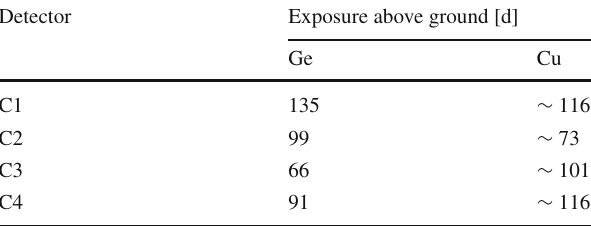
Fig. 13 Contribution of the decay of cosmogenic isotopes evaluated with the MC simulation in comparison to background data of C1 in April 2018 in the highE range Table5 TotalexposureabovegroundoftheGeandCuemployedinthe CONUS experiment. While for Ge the exposure was tracked exactly, there are larger uncertainties for the Cu parts. During the manufactur- ing process, all of these materials were kept underground as much as possible to avoid cosmic activation Detector Exposure above ground